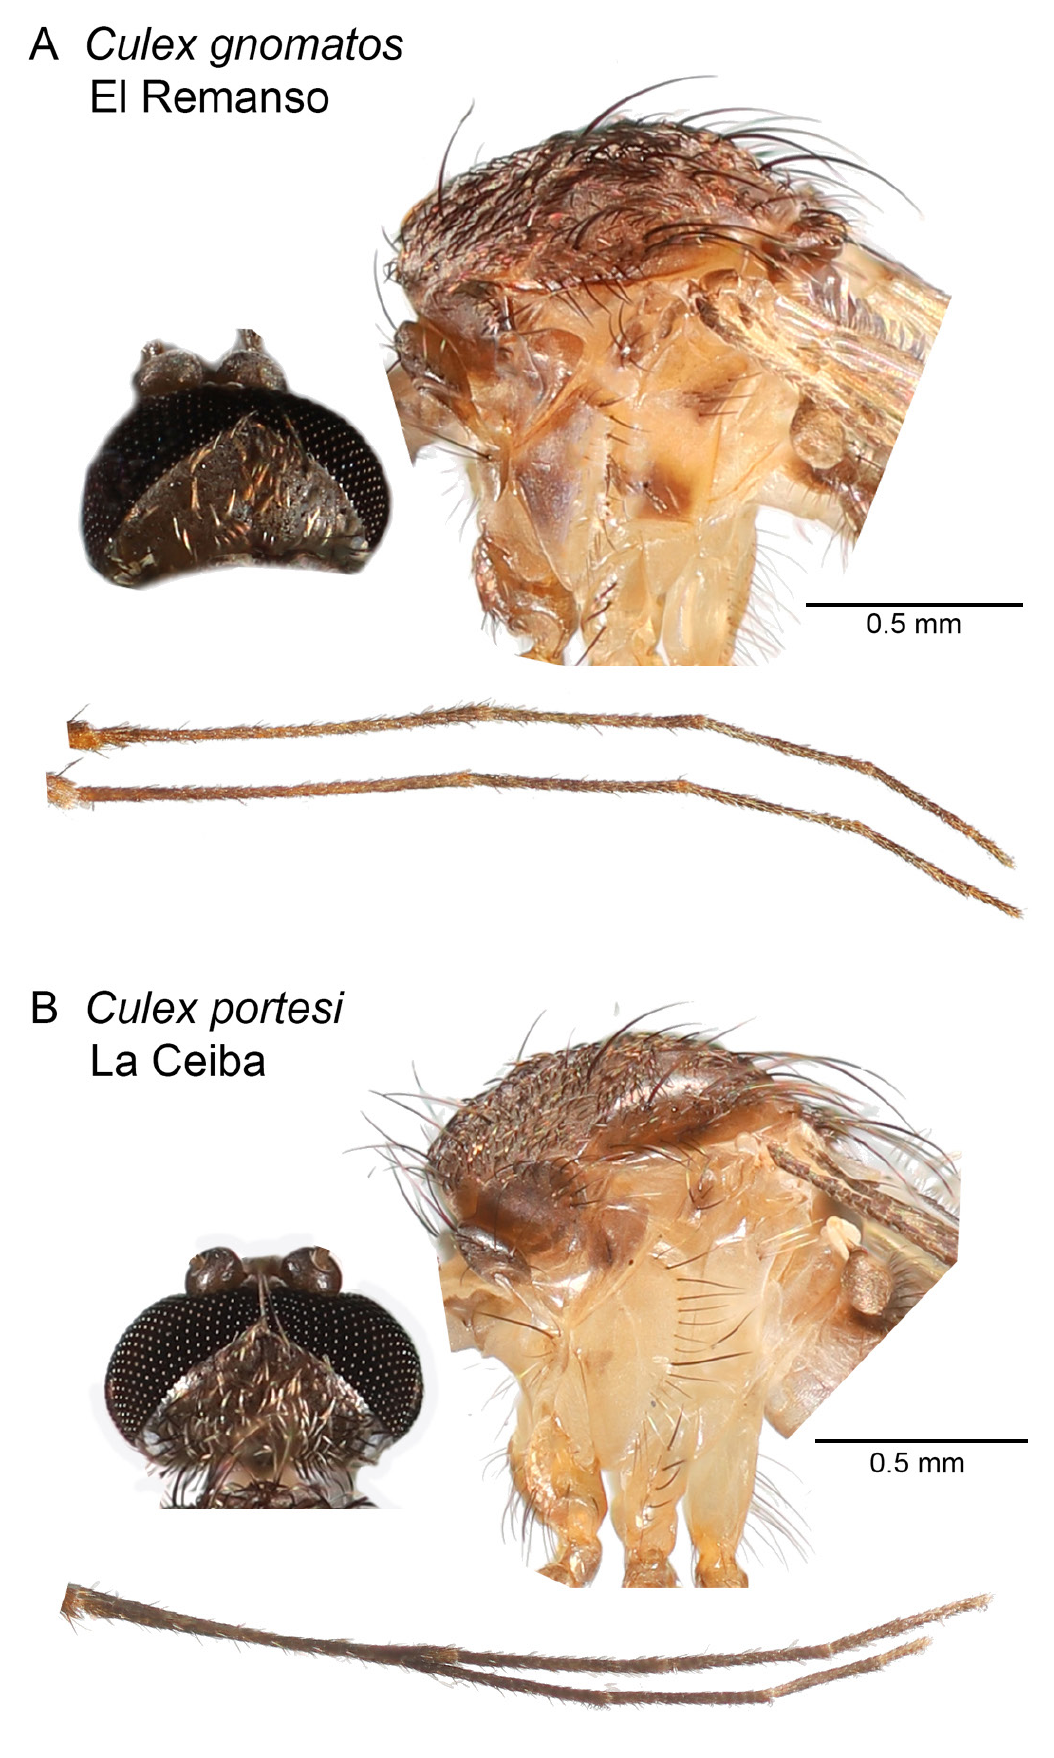
Figure 1. Spissipes section females from Guainía, Colombia. A. Culex gnomatos , occiput, pleuron, and hind tarsi. B. Culex portesi , occiput, pleuron, and hind